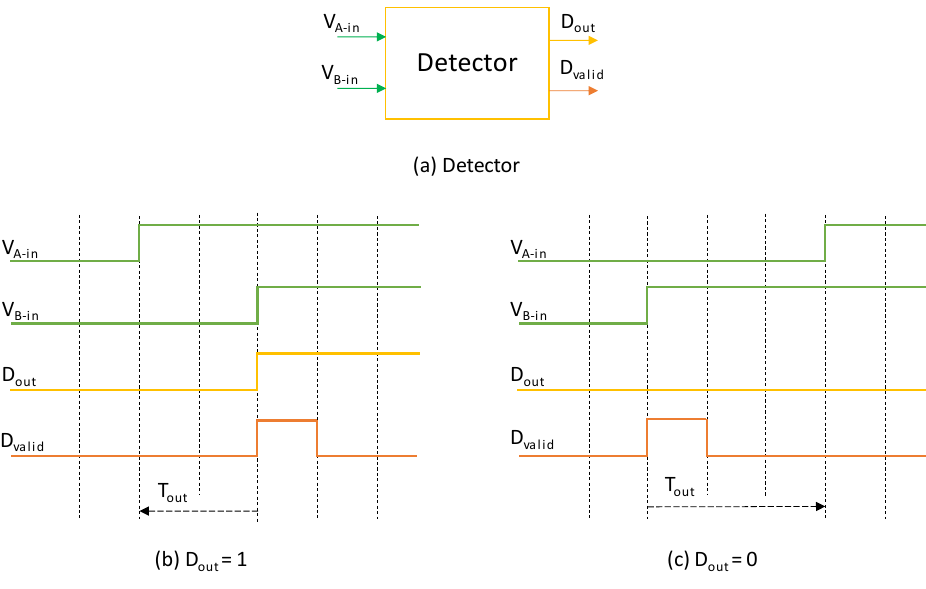
Figure 4. Results detection structure based on time domain.